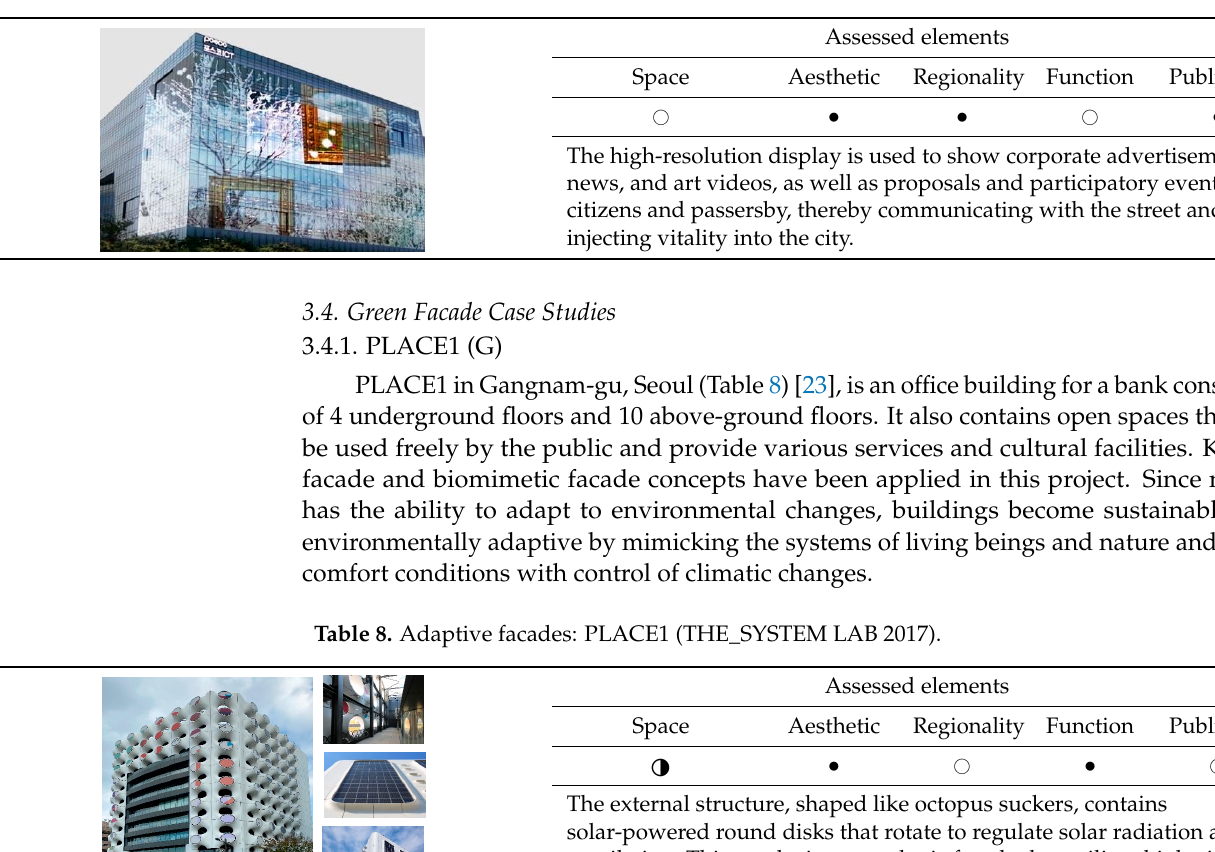
Table 7. Media facades: Smart Tower (Posco A&C 2011).